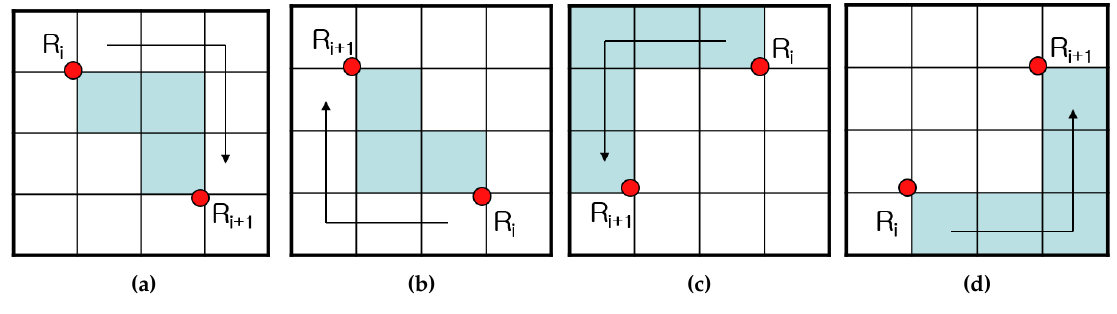
Figure 13. Contour pixel reconstruction. ( a ) SE; ( b ) NW; ( c ) SW; ( d ) NE.